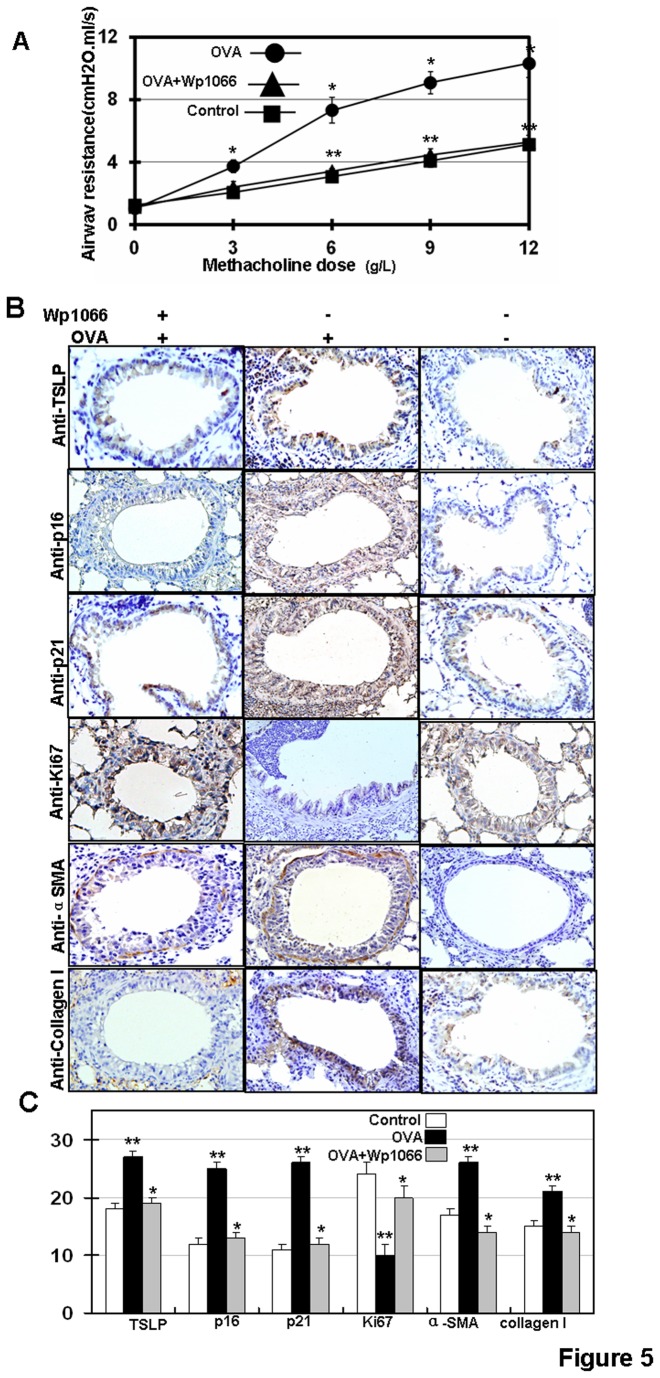
Experimental therapies with WP1066 in OVA-challenged chronic asthmatic mice.(A) OVA-challenge was performed in BALB/c mice as described [28]. WP1066 was administered by intraperitoneal injection at doses of 40mg/kg 1h before the OVA-challenge. Airway resistance was measured using increasing concentration of methacholine and assessed using the flexiVent system. Results are expressed as the mean of experiments done in triplicate ± the standard error of the mean (SEM) (* p<0.05, **p>0.05
vs
control). (B) TSLP, p16, p21, Ki-67, α-SMA and collagen I protein expressions were analyzed, 200×. (C) Bimodal H score distribution of TSLP, p16, p21, Ki67, α-SMA and collagen I immunoperoxidase reactions are presented.